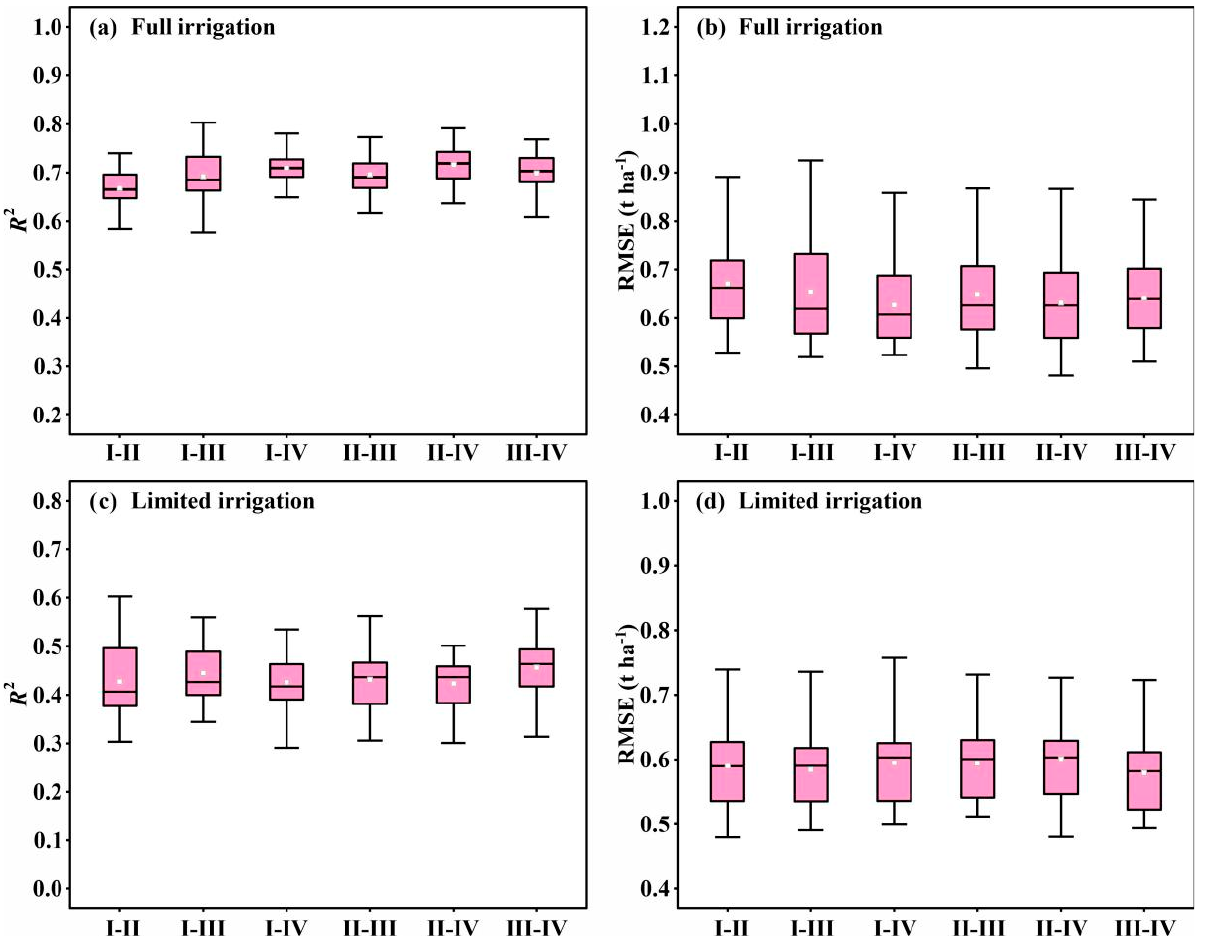
Figure 5. ( a – d ) The statistical distributions of model performance for predicting grain yield of six joint time-points stacking two growth stages under full and limited irrigation treatments. I-II, stacking traits from flowering and early grain fill. I-III, stacking traits from flowering and mid grain fill. I-IV, stacking traits from flowering and late grain fill. II-III, stacking traits from early and mid grain fill stages. II-IV, stacking traits from early and late grain fill. III-IV, stacking traits from mid and late grain fill.